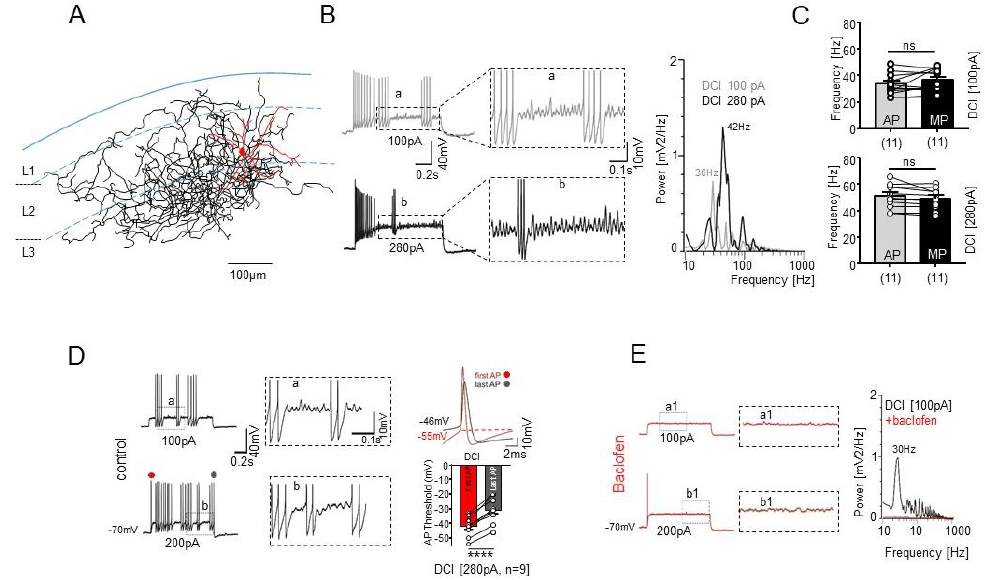
Figure 5. Subthreshold membrane potential oscillations and firing of STUT. ( A ) Neurolucida re- construction of a biocytin-filled PV-immunopositive STUT. ( B ) Subthreshold oscillations in STUT upon depolarizing current injection with different intensity ( left ) and the corresponding power spectra ( right ). The peak frequency of membrane oscillations varied depending on the intensity of injected pulses but remained at the gamma frequency range (30 Hz and 42 Hz). a, b (framed, middle )—enlarged display of a, b (framed, left ). ( C ) Summary bar charts of the peak frequency of subthreshold membrane oscillations and firing of APs upon 100 pA and 280 pA DCI. Note no significant population difference between subthreshold oscillations and AP firing frequency. p value is given as ns ( p > 0.05). ( D ) Examples of STUT responses upon 100 pA and 200 pA DCI. Upon DCI, STUT generate one AP or burst of spikes interrupted by subthreshold gamma band membrane potential oscillations followed by AP trains at the same gamma frequency range ( left ). a, b (framed, middle )—enlarged display of a, b ( left ). The first ( • ) and last ( • ) APs possess significantly different AP threshold ( right ). p value is given as **** ( p ≤ 0.0001). ( E ) Effect of GABA B receptor agonist ba- clofen on the intrinsic membrane properties of STUT held at the same membrane potential ( − 70 mV) as those in control in ( D ). Baclofen strongly suppressed the intrinsic oscillations and AP firing ( left ). a1, b1 (framed, middle )—enlarged display of a1, b1 (framed, left ). The corresponding power spectra of subthreshold oscillations upon 100 pA DCI before (black) and after (red) baclofen